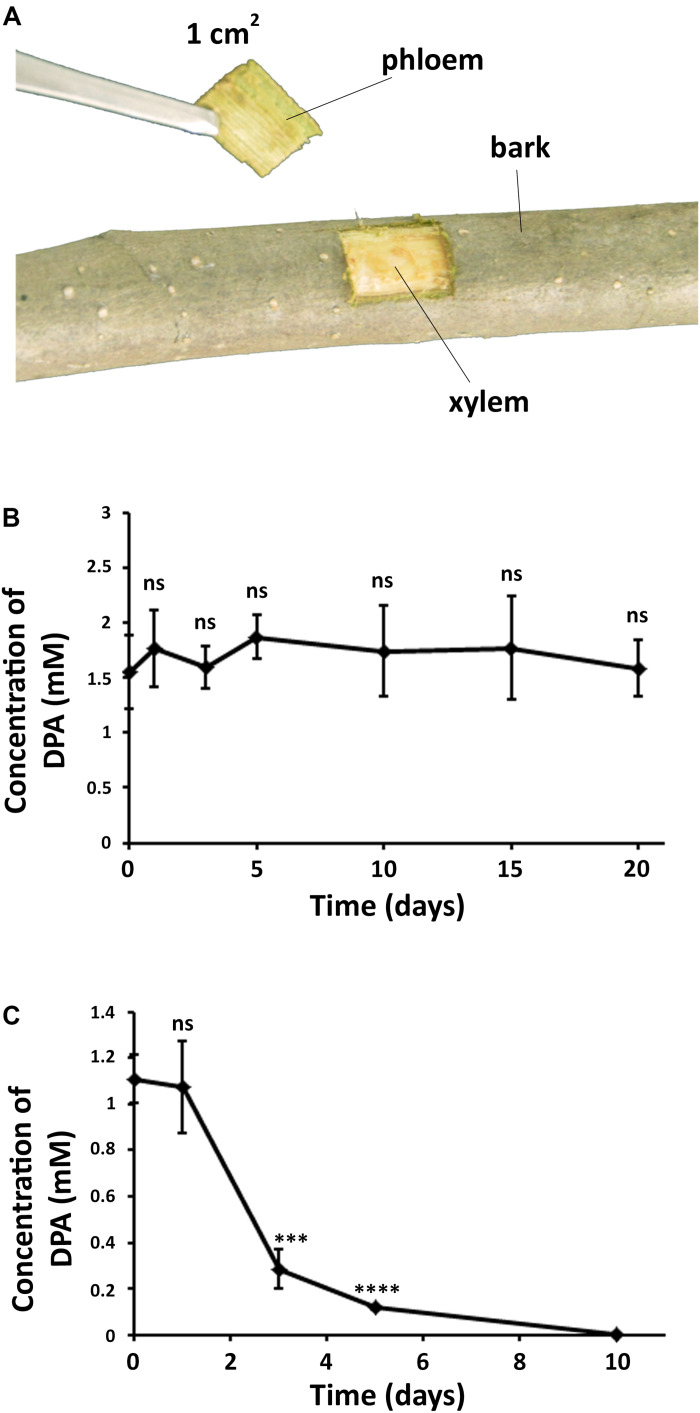
Diffusion and stability of DPA in the pear trunk. (A) Extraction of samples from DPA-treated branches in pear trees. DPA treatment was carried out by spraying a 12 mM DPA solution (300 mL) on the pear branches. (B) Concentration of DPA in pear bark over time. (C) Concentration of DPA in pear phloem over time. The obtained results indicated that DPA can cross the pear bark and shows high stability in the pear bark. Ten samples were collected for each time point. Significance levels at ***P < 0.001, ****P < 0.0001, and no significance (ns).